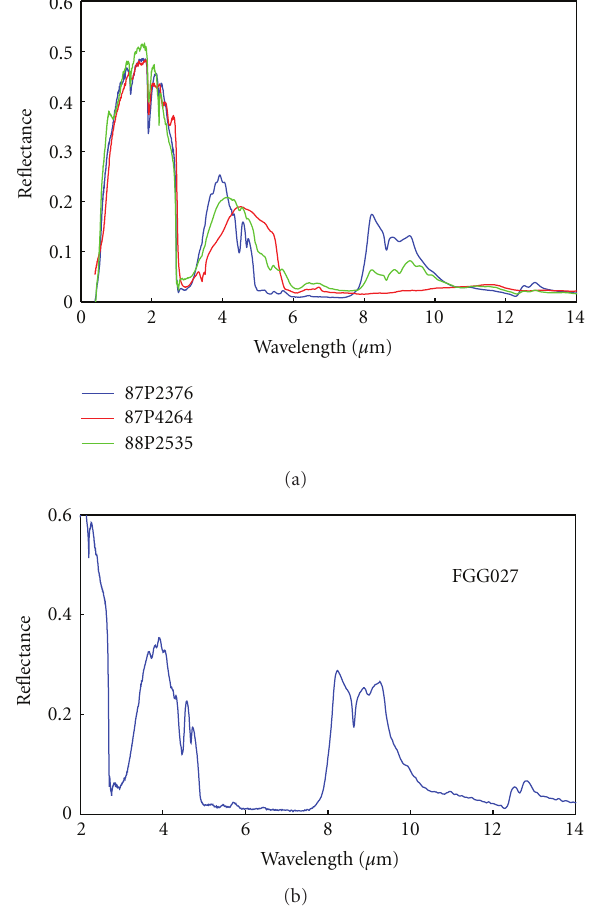
Figure 11: (a) Examples from the USDA soil spectra included within the ASL. (b) Example from the semiarid Fowlers Gap (Australia) included in the ASL